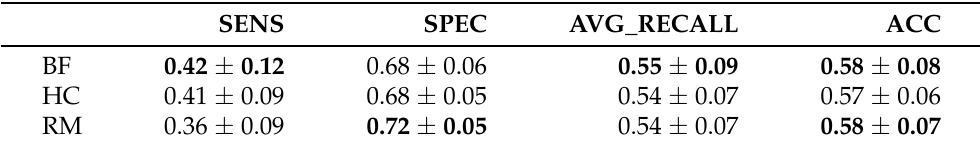
Table 6. Bayes average performance metrics over the Granger experiment set { G ( l ) } : sensitivity (SENS), specificity (SPEC), average recall (AVG_RECALL), and accuracy (ACC) evaluated for the Bayes networks (HC, BF, and RM). The metrics represent the level of accordance between the Bayes causality models and the collection of results obtained by the Granger experiments. In bold the best